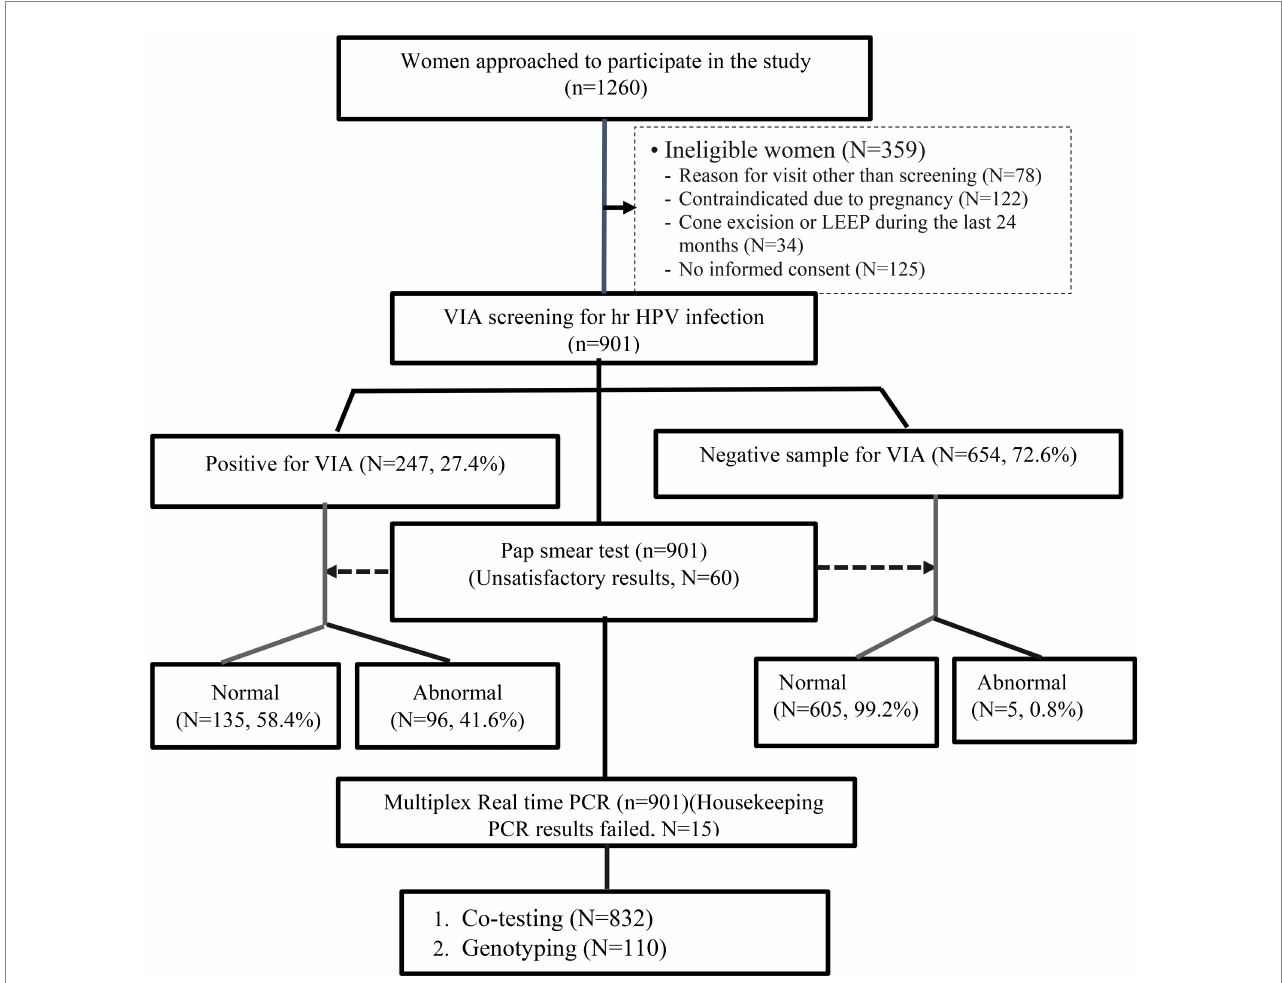
FIGURE 2 Flowchart for the liquid-based cytology and HPV DNA testing performed on the study population.